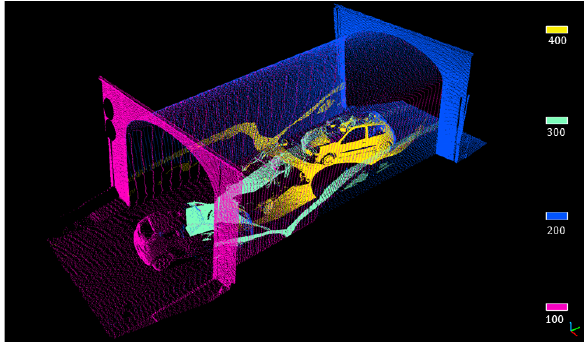
Figure 8. Point cloud after combining the four scans.